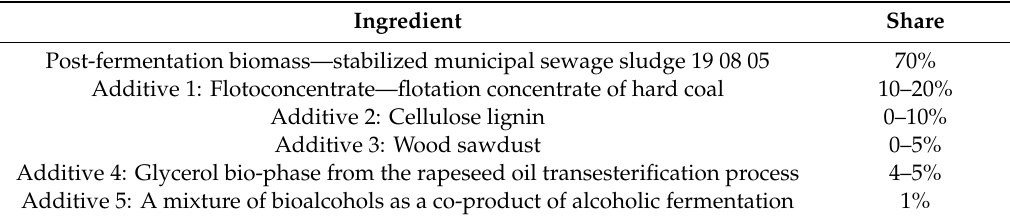
Table 2. Optimal content of the mixture.